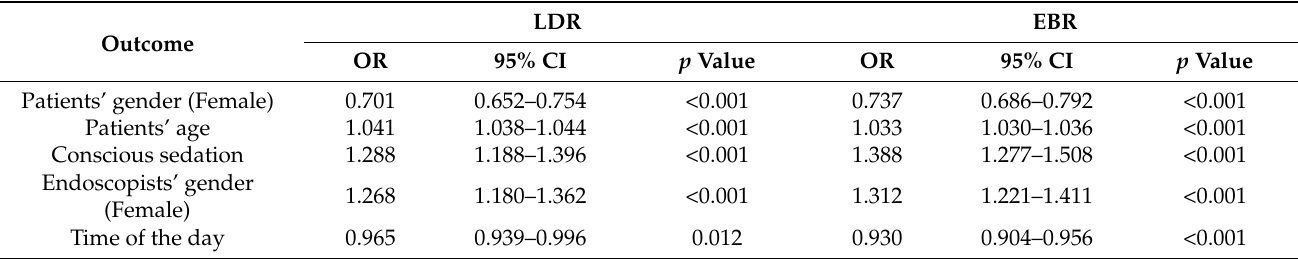
Table 4. Multivariable logistic regression